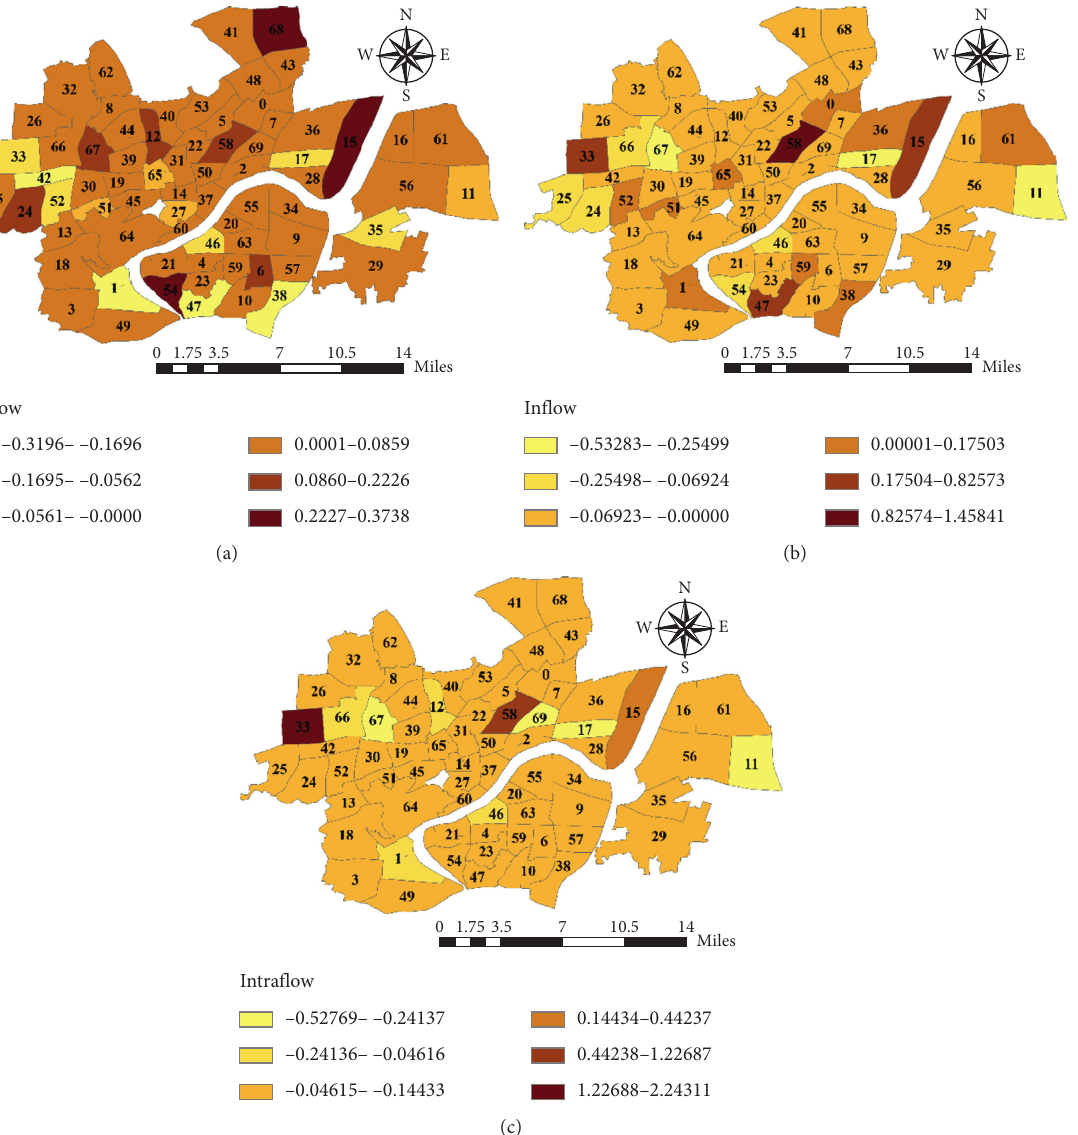
Figure 6: OD flow changes due to the residential area change in 2050. (a) Outflow change ratio. (b) Inflow change ratio. (c) Intraflow change ratio.